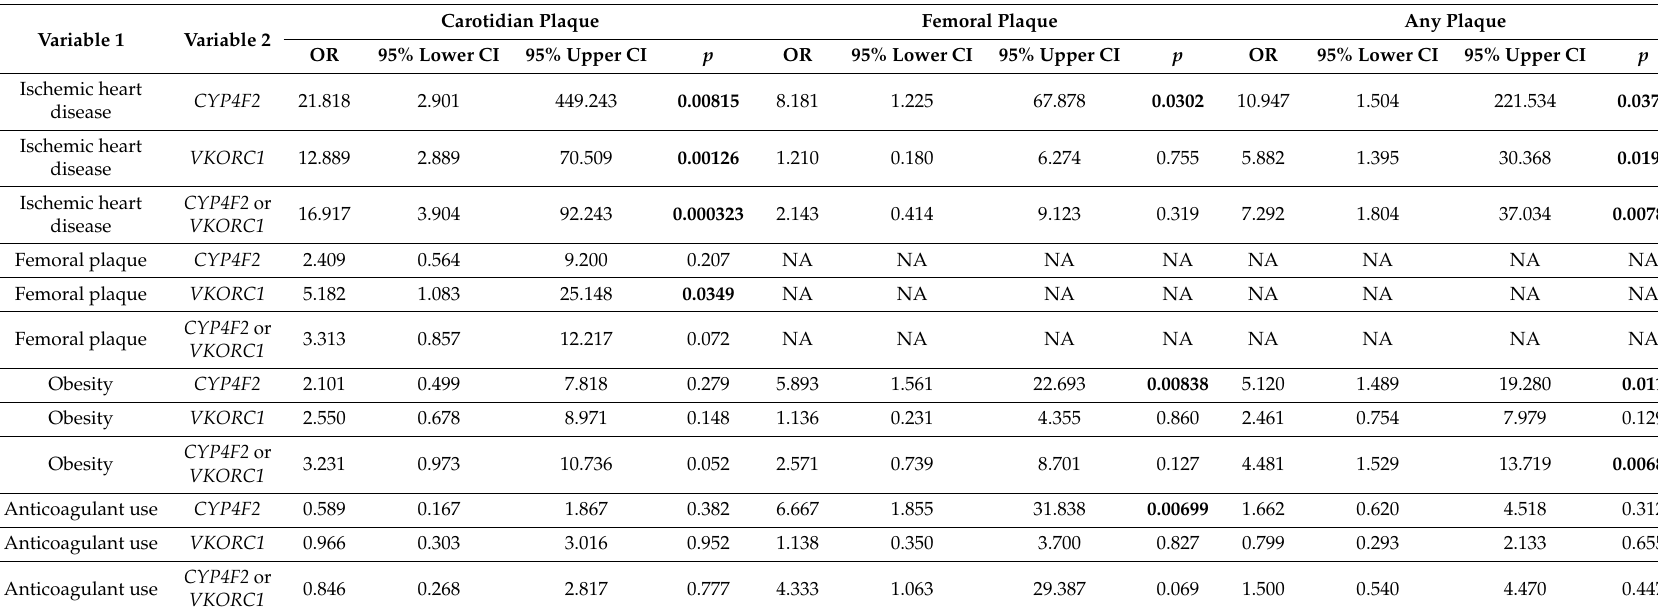
Table 4. Interaction assessment for the variables of interest. VKORC1 and CYP4F2 mutational status was dichotomized between no mutation and either monoallelic or biallelic